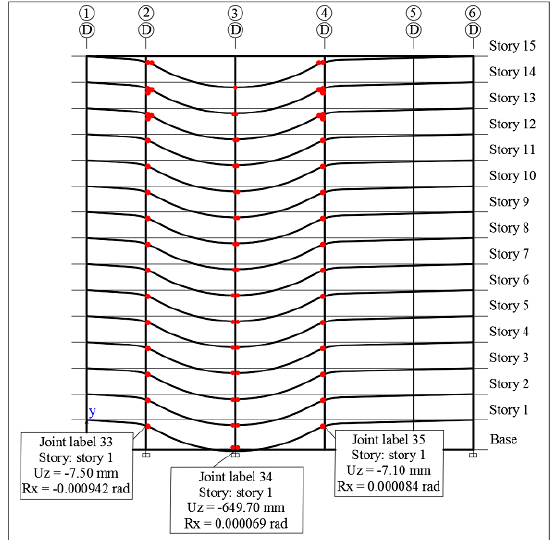
Figure 14. Displacement at notionally removed column D3 (part of grid line D) when moment frames are located at perimeters and along grid lines B, C, D, E, F and G (non-linear static analysis case 21).